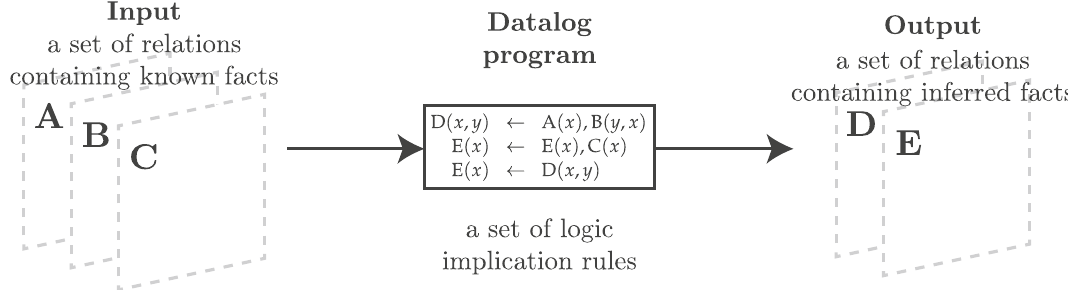
Figure 6. Deductive inference in Datalog. Using knowledge and implication rules to infer new